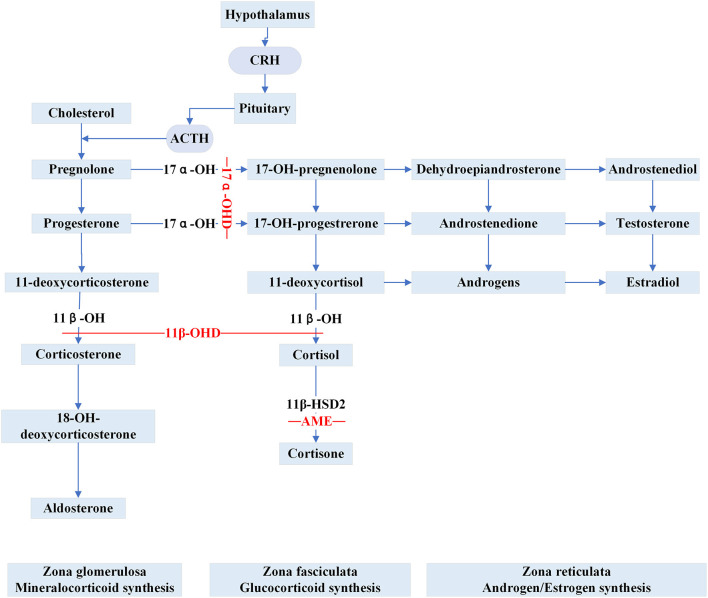
Steroid synthesis pathway and reduced activity of peripheral steroid hormone-metabolizing enzymes that catalyze the synthesis or inactivation of the corresponding hormones (11β-OHD, 17α-OHD, AME). 11β-OH, 11β-hydroxylase enzyme; 11β-OHD, 11β-hydroxylase deficiency; 17α-OH, 17α-hydroxylase enzyme; 17α-OHD, 17α-hydroxylase deficiency; 11β-HSD2, 11β-hydroxysteroid dehydrogenase type 2; AME, apparent mineralocorticoid excess.